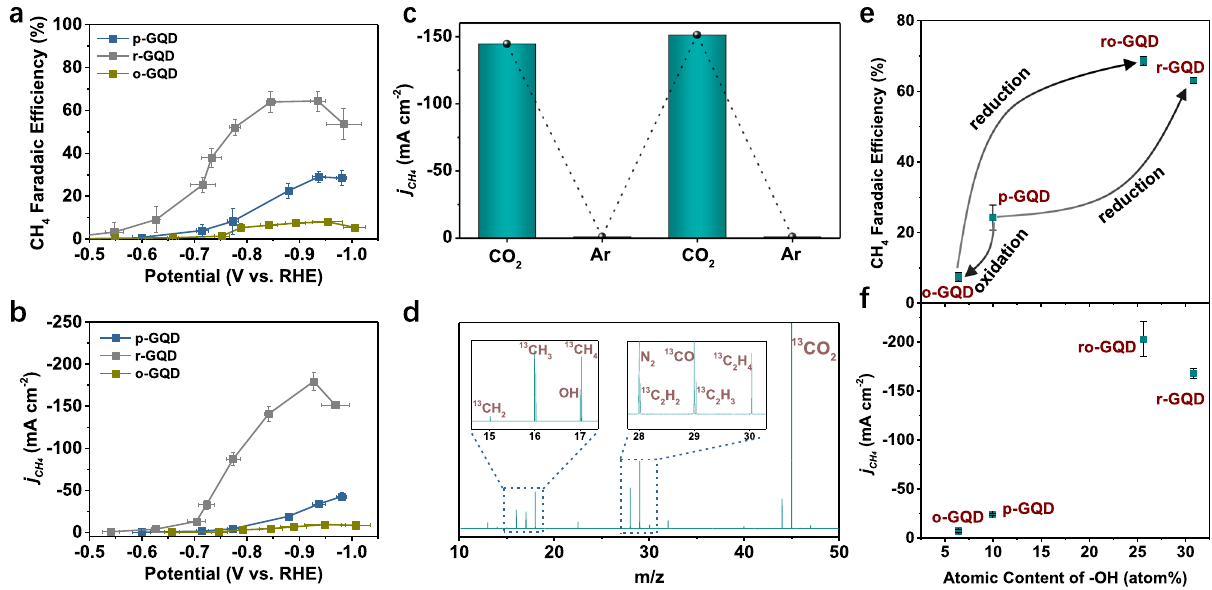
Fig. 1 Performance of functionalized GQDs for the electrochemical reduction of CO 2 . a and b Faradaic ef fi ciency ( a ) and partial current density of CH 4 ( j CH4 ) ( b ) as a function of applied potentials on GQDs prepared under different conditions. c The j CH4 for r-GQDs when alternatively supplying CO 2 and Ar feedstocks. d The mass spectroscopy results of CO 2 reduction on r-GQDs when using isotopically labeled 13 CO 2 as the feedstock. The insets demonstrate the m / z signals for isotopically labeled 13 CH 4 and 13 C 2 H 4 . e and f The Faradaic ef fi ciency of CH 4 ( e ) and j CH4 ( f ) as a function of the – OH content in the p- GQDs, o-GQDs, r-GQDs, and ro-GQDs. In Fig. 1e, f, a positive correlation between CH 4 production activity and – OH content was observed. The error bars represent the standard deviation from at least three independent